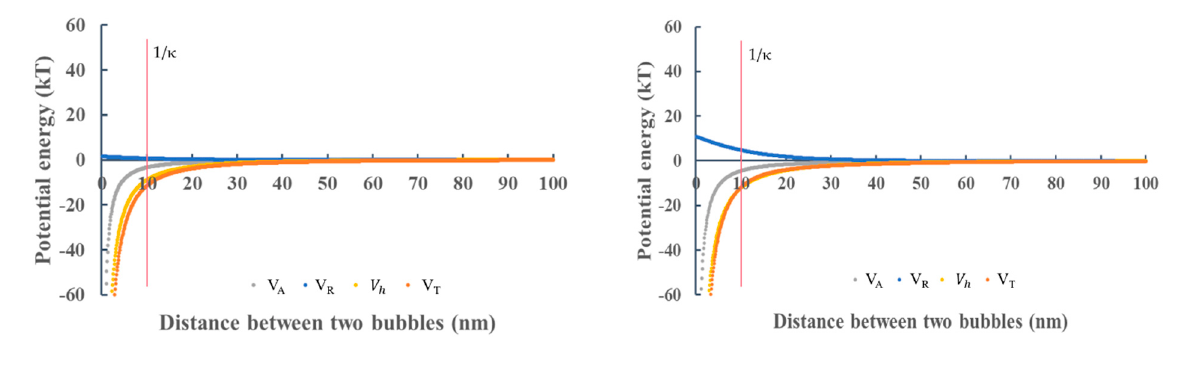
Figure 10. Total potential energy V T as a function of the distance between two nanobubbles at − 5 mV zeta potential on the